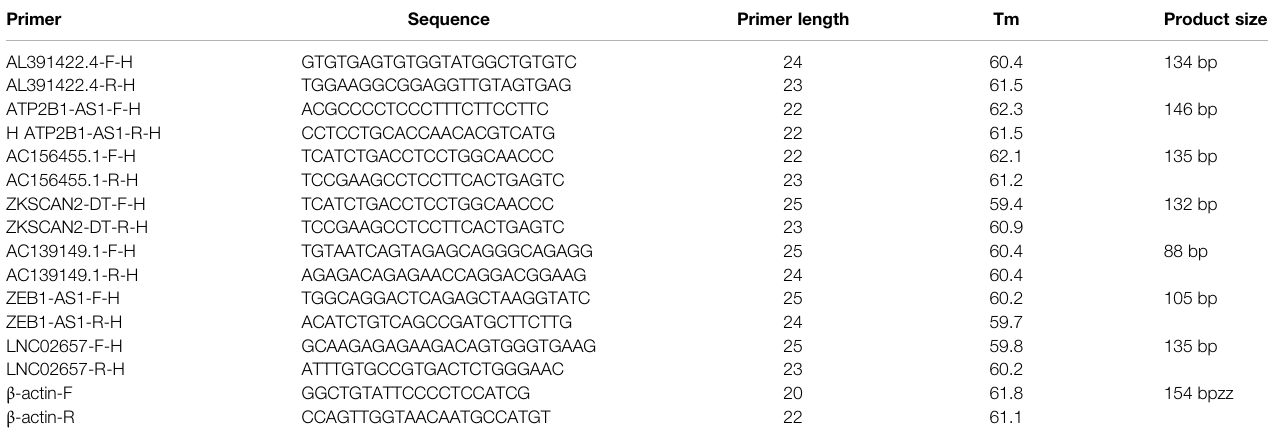
TABLE 1 | Primers used in qRT-PCR. Primer